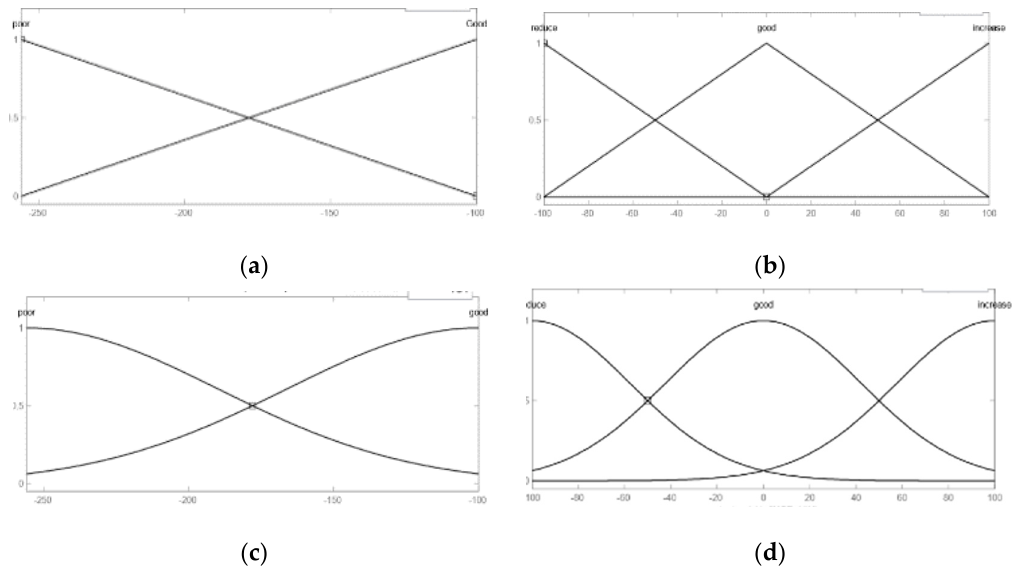
Table 3. Variable range of the membership functions.